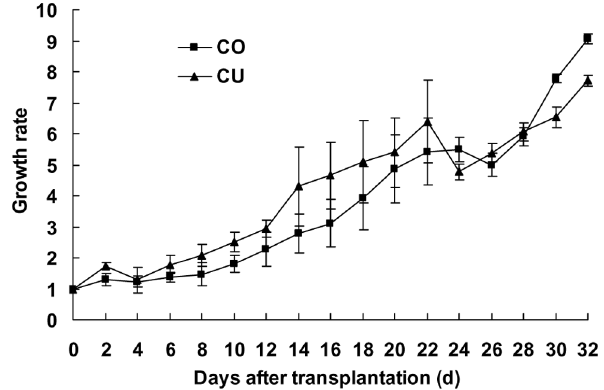
Figure 3. Growth rates of the cotton-specialized aphids (CO) and cucurbits-specialized aphids (CU) on cowpea. Bars are means 6 1SE.